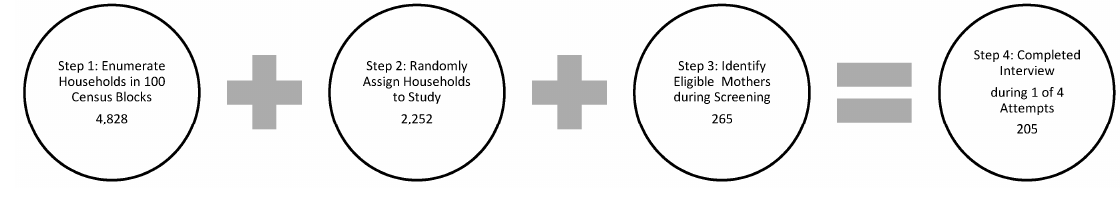
Figure 1. Sample Framework.